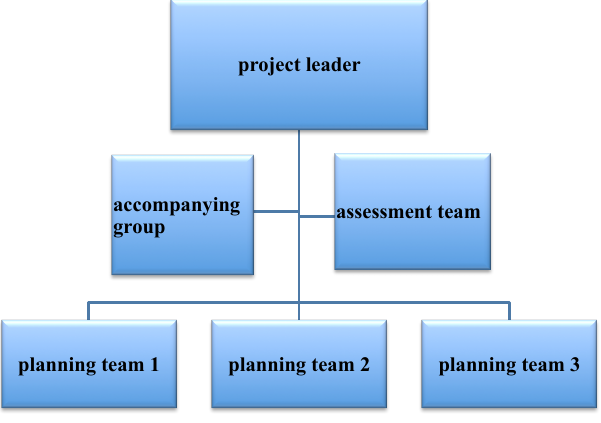
Figure 4: Organigram of the flood prevention project. Source: Building Department of the Canton of Zurich,